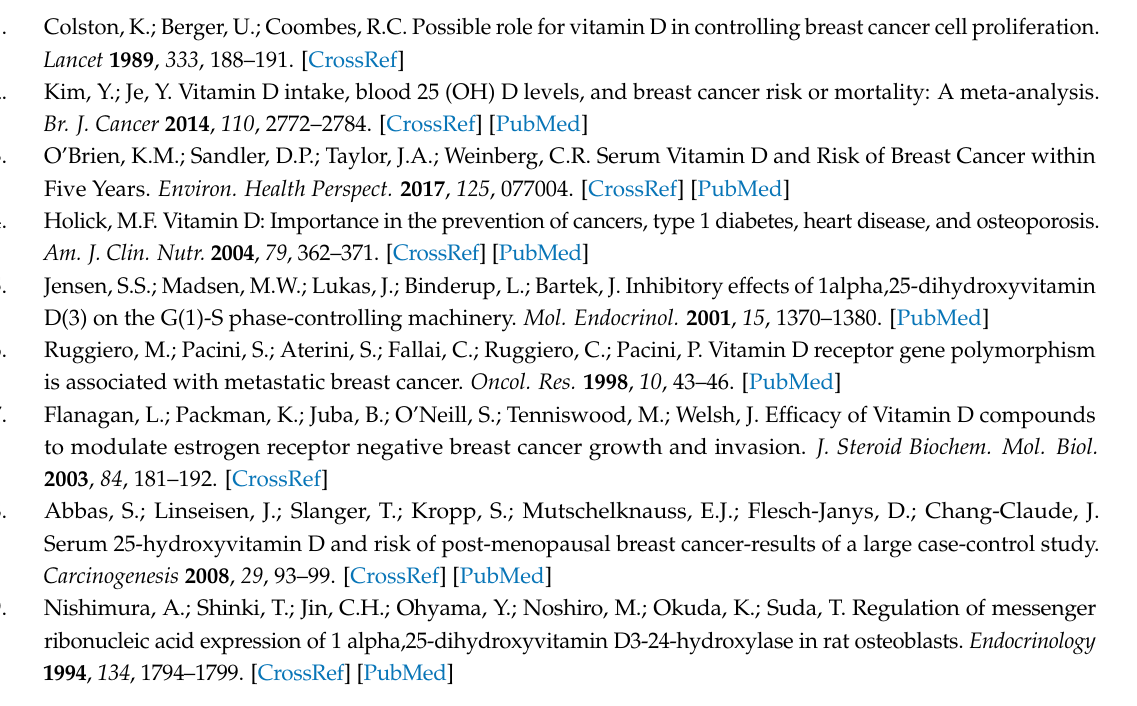
Table S1: Characteristics of study participants according to centre. Table S2: Odds ratio (OR) and 95% confidence interval (CI) for the association between factors and plasma 25(OH)D status (<50 nmol/L) among breast cancer